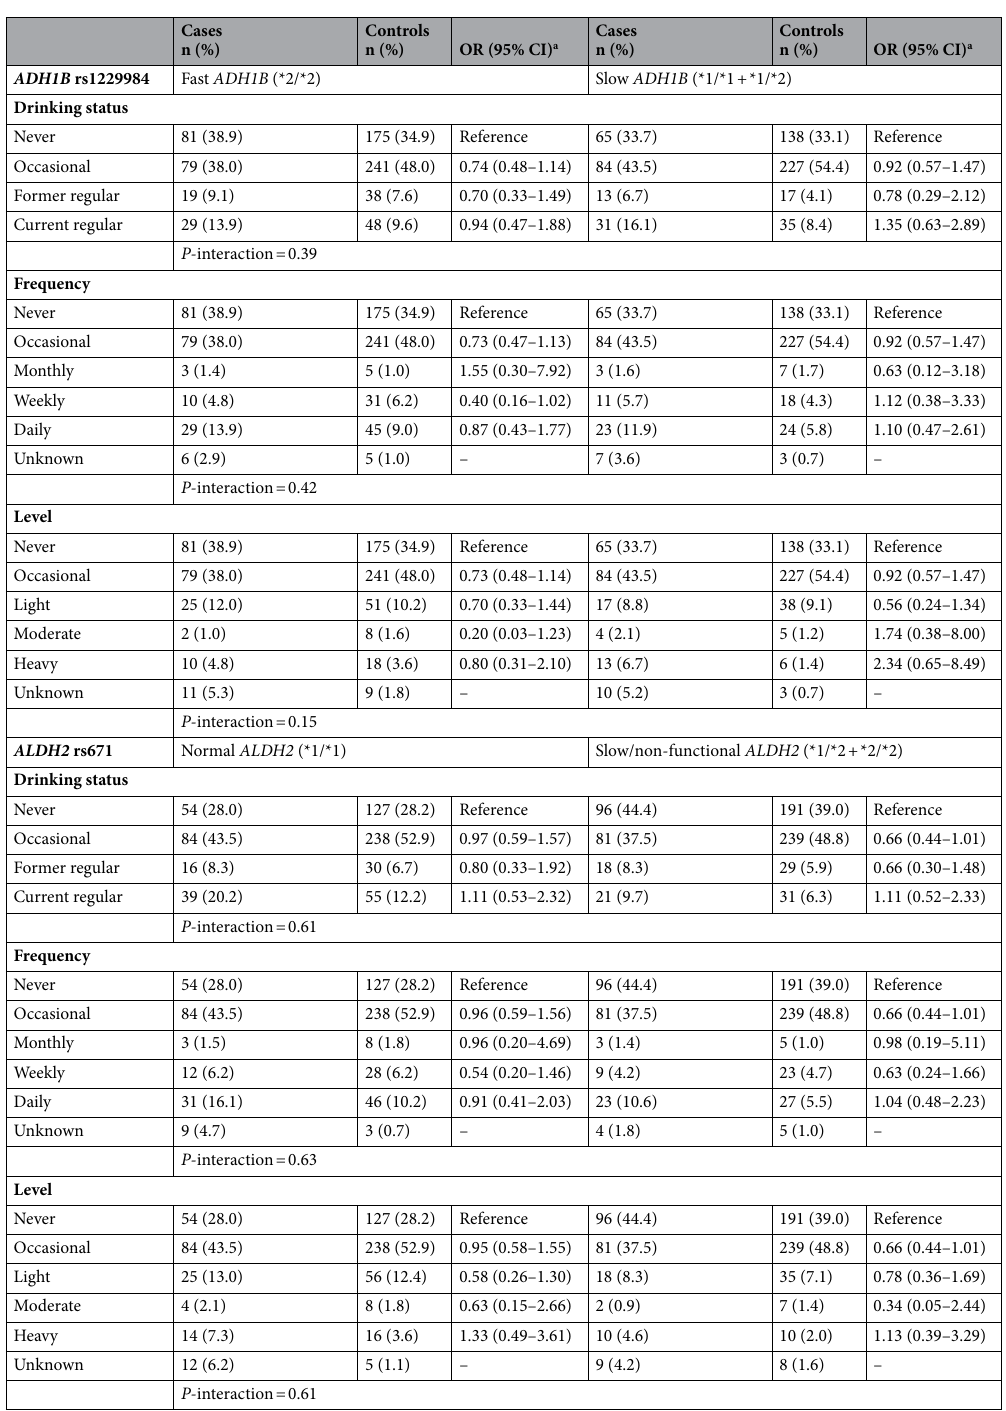
Table 5. The association between alcohol drinking and pancreatic cancer risk stratified by the genotypes of ADH1B or ALDH2. CI confidence interval, N number, OR odds ratio. a OR and 95% CI were calculated using unconditional logistic regression, adjusted for sex, age, education, cigarette smoking (pack-years), oral hygiene score, vegetable consumption, allergy, diabetes/glucose intolerance and BMI at two years before the pancreatic cancer diagnosis for the cases or before the interview date for the